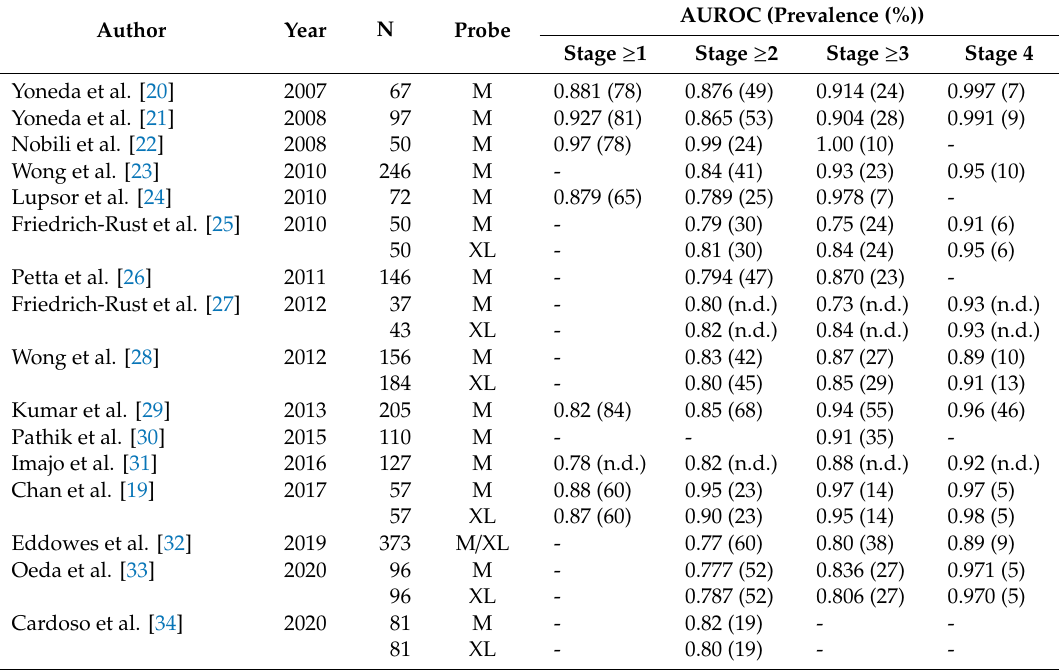
Table 1. Diagnostic accuracy for liver fibrosis in patients with